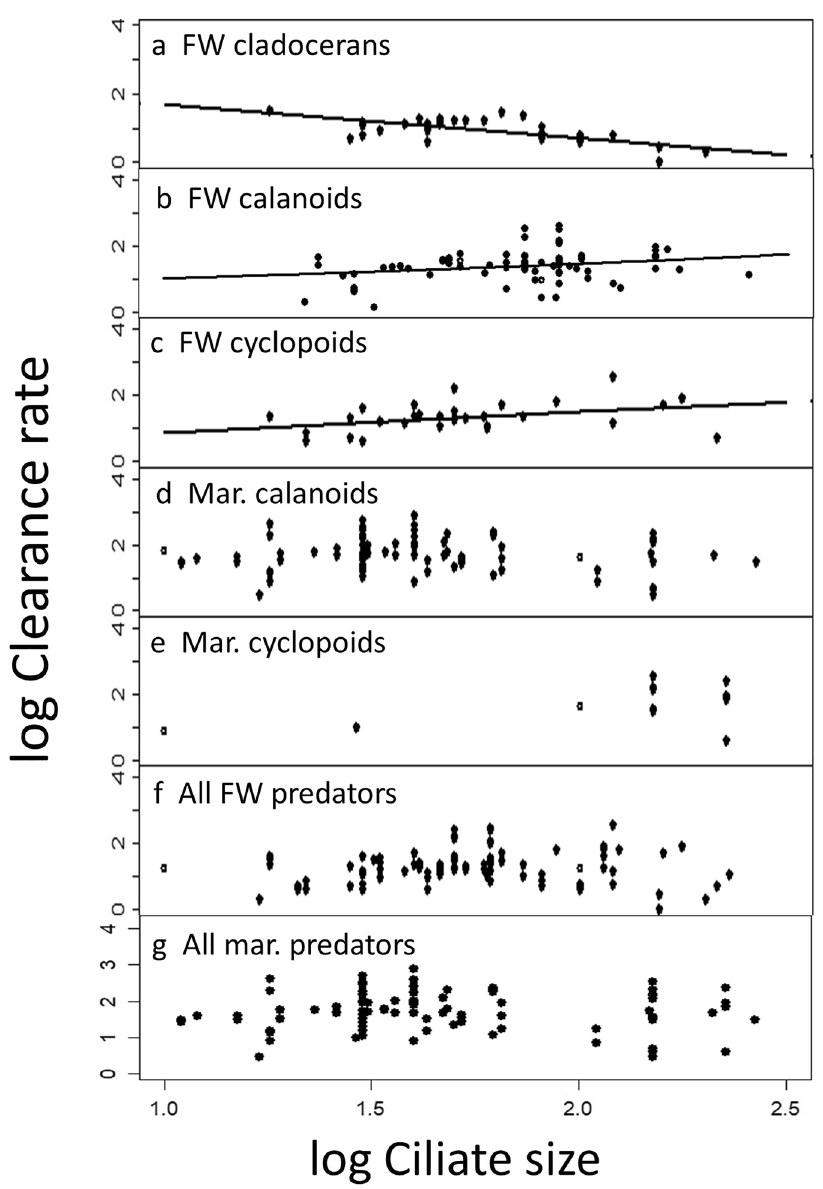
Figure 5. Log 10 –transformed clearance rates (logCL, in mL individual −1 d −1 ) of the major functional groups of microcrustacean predators vs the ciliate size. Data were fitted by linear regression (a) and a power function (b,c), respectively. Curve fitting failed for the data shown in panels d–g. FW denotes freshwater, Mar and mar = marine. All model results are reported in Suppl. Table